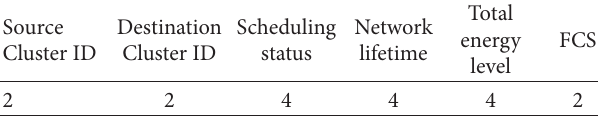
Table 1: Proposed packet